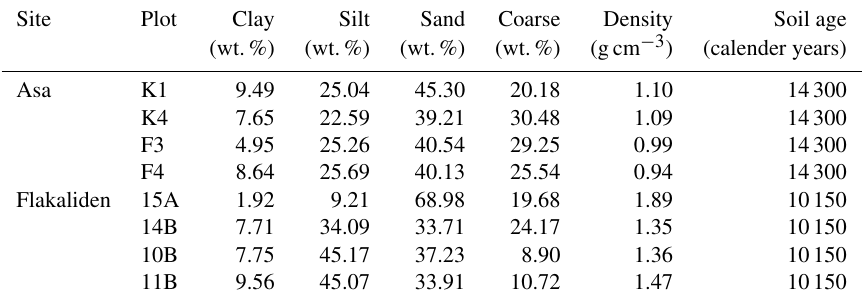
Table 1. Soil profile characteristics at 50cm depth in the mineral soil at the Asa and Flakaliden sites. Site Plot Clay Silt Sand Coarse Density Soil age (wt.%) (wt.%) (wt.%) (wt.%) (gcm − 3 ) (calender years) Asa